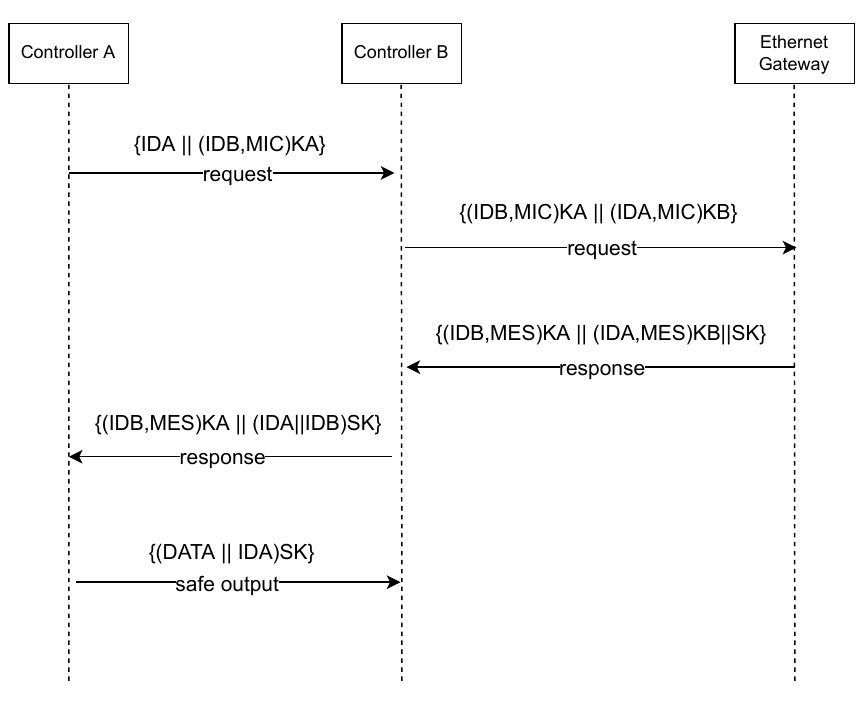
Figure 3. SOME/IP Message